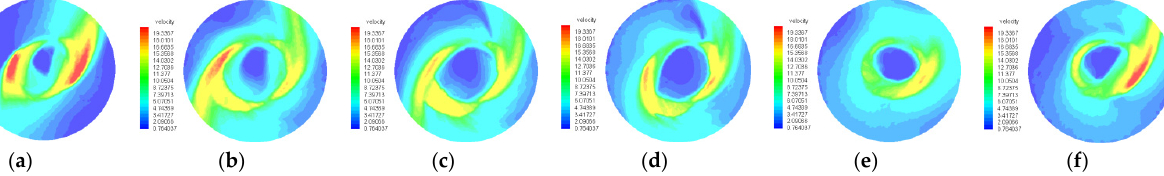
original suction cup with time in adhesion interface plane at: ( a ) 5 ms, ( b ) 9.4 ms, ( c ) 13.8 ms, ( d ) 18.2